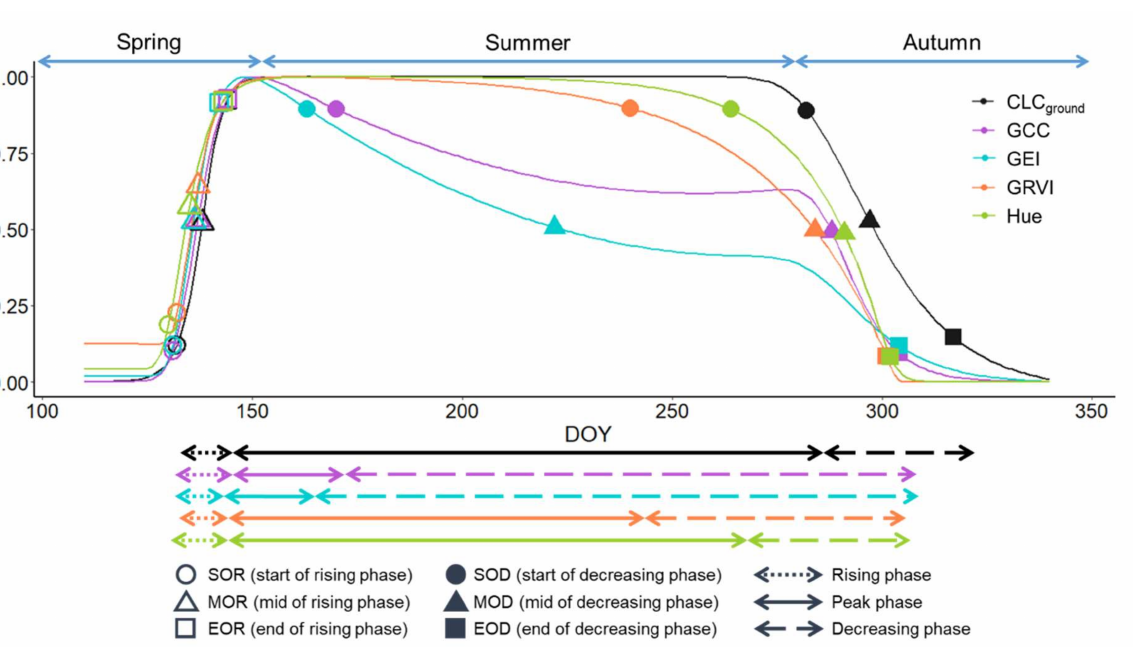
Figure 1. Seasonal trajectories of leaf phenological metrics for Betula grossa Siebold & Zucc. measured in 2020, with a visual explanation of seasons (thin arrows in the upper part of the panel; spring, April–May; summer, June–September; autumn, October–November), phenophases (thick arrows below the panel), and phenological transition dates (symbols). Solid lines are the fitted results of double logistic models. All values are normalized to the scale from 0 to 1. The data points used for curve fitting and the other trees’ data are shown in Figure A5. Abbreviations: DOY, day of the year; CLC ground , crown leaf cover based on the ground observation; GCC, green chromatic coordinate; GEI, green excess index; GRVI, green-red vegetation